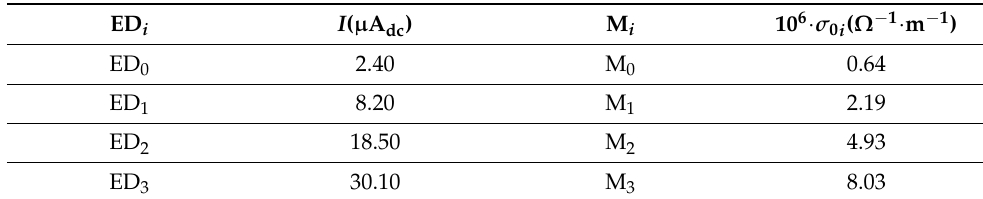
Table 4. The electric current intensities, I , through Eds, and the conductivities σ 0 i ( i = 0,1,2,3 ) of Ms at B = 0